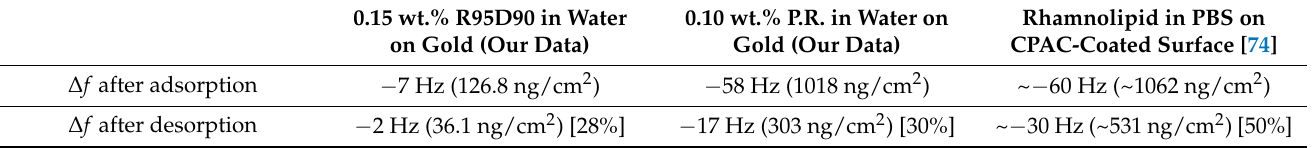
Table 3. Frequency shift data and mass data of R95D90 or P.R. rhamnolipid adsorption on gold surface and of rhamnolipid (R1:R2 = 1:5) adsorption on CPAC-coated